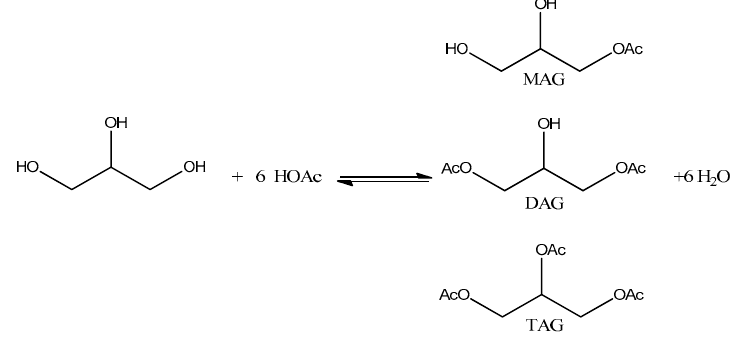
Figure 1. Industrial applications of glycerol esters (adapted from ref. [33]).